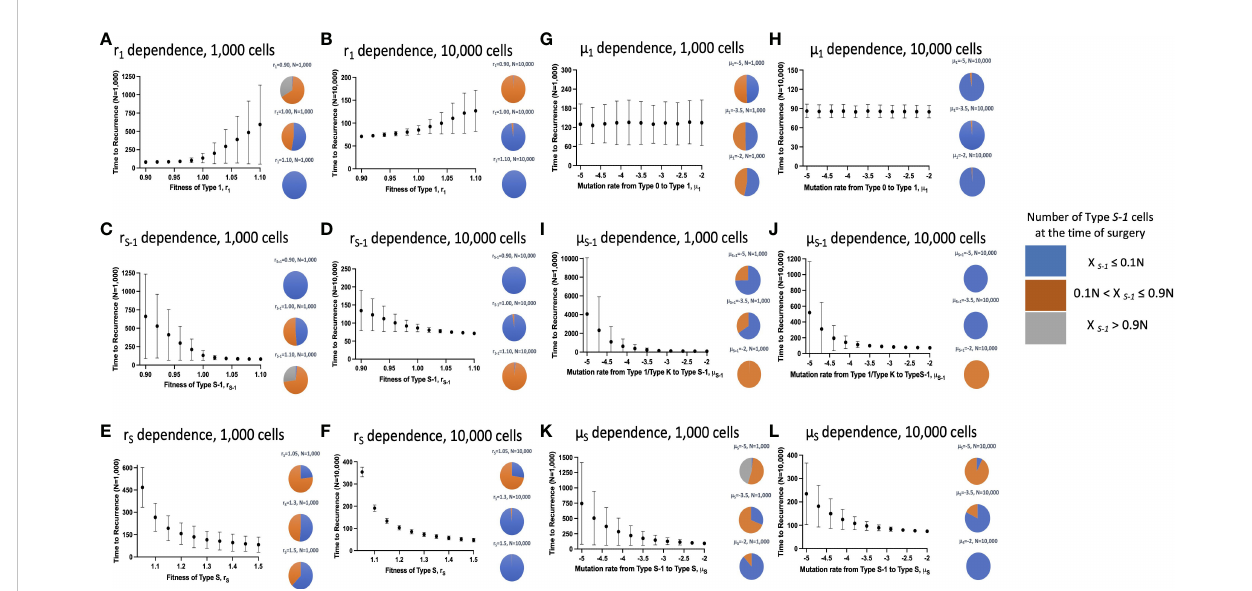
FIGURE 3 Parameter dependence on recurrence time. Simulation studies without spatial structure are shown. Mean values obtained from 100 to 1,000 simulations are shown by dots, and standard deviations are indicated by bars. Pie charts in the panels indicate the proportion of Type S -1 cells in a normal tissue at the time of fi rst treatment. Blue, orange and grey represent small ( X S -1 ≤ 0.1 N ), intermediate (0.1 N < X S -1 ≤ 0.9 N ), and large ( X S -1 > 0.9 N ) proportion of Type S -1 cells, respectively. Standard parameter values used in (A – L) are d = d s = 1.0, r 0 = 1.0, r 1 = 1.0, r S -1 = 1.2, r S = 1.0, m 1 =